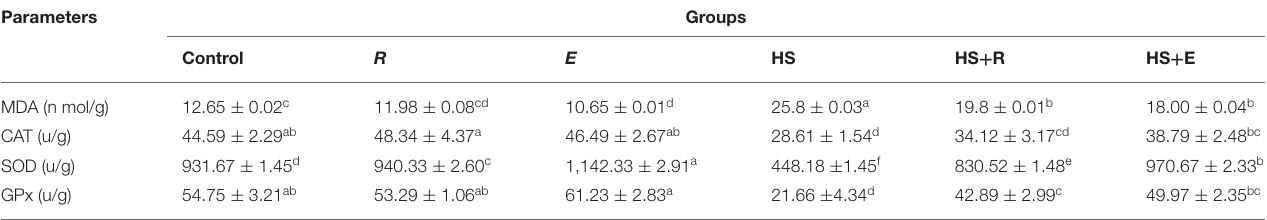
TABLE 7 | Effects of supplementation with digestive enzymes and/or Ruminococcus sp. on the liver tissue antioxidants and peroxide of chickens’ blood serum at 42 days. Parameters Groups